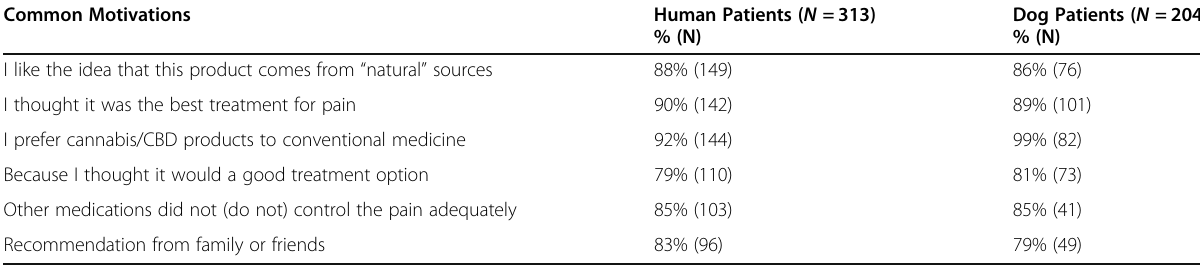
Table 7 Percentages of Respondents Who Felt their Expectations were Met and Motivations for using Cannabis Products Common Motivations Human Patients ( N = 313) %